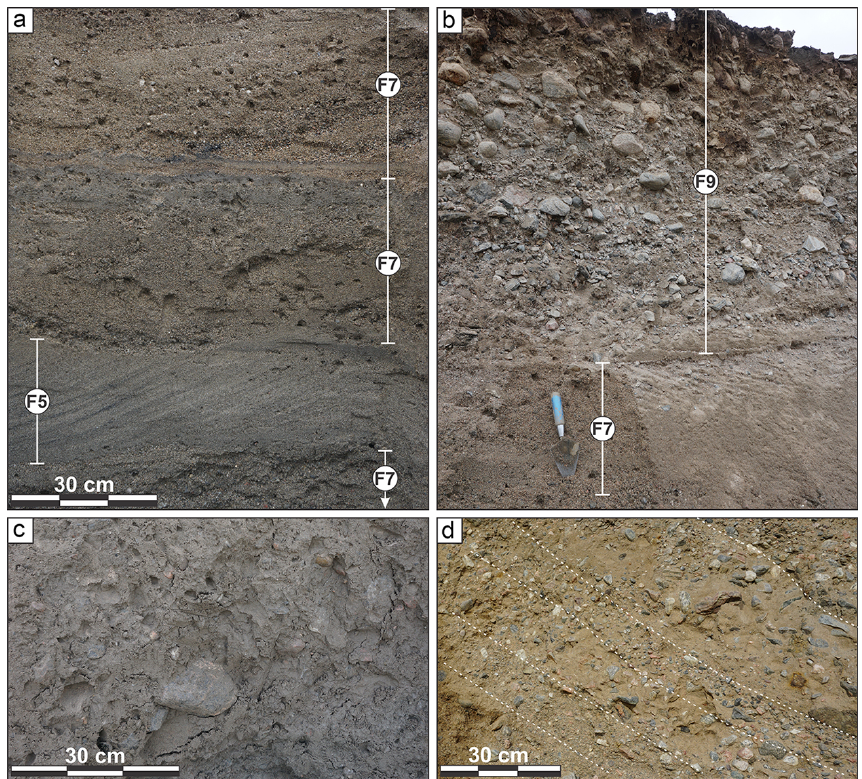
Figure 3. Coarse-grained sedimentary facies. (a) Cross-stratified sands (facies 5) and massive pebbly sands (facies 7). Image from S3 at 6ma.s.l. (b) Massive gravels (facies 9) and massive pebbly sands (facies 7) at S9 (41ma.s.l.). Note trowel is 30cm in length. (c) Diamicton (facies 1) – the lowermost exposed unit at S7 (ca. 14ma.sl.). (d) Cross-stratified gravels and pebbly sands (facies 8) at S6 (ca. 27ma.s.l.). Individual strata are separated by dashed